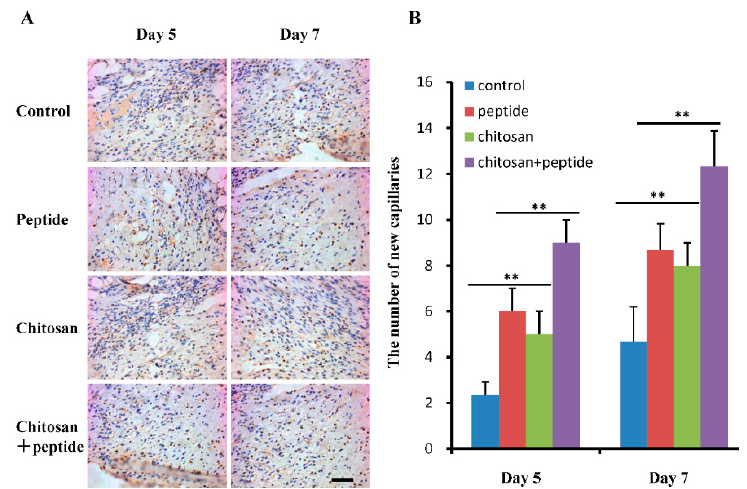
Figure 3. A SIKVAV-modified chitosan hydrogel promotes angiogenesis in skin wounds. ( A ) Immunohistochemical detection of CD31 expression in vascular endothelial cells of skin wounds on days 5 and 7 after surgery in control, SIKVAV, chitosan, and SIKVAV-modified chitosan group mice (scale bar: 50 μ m). ( B ) Statistical analysis of new blood capillaries in control, SIKVAV, chitosan, and SIKVAV-modified chitosan group mice ( n = 3, ** p <